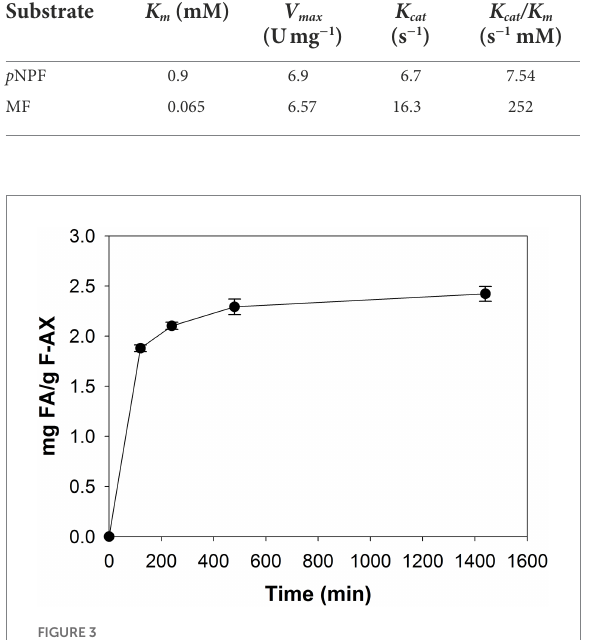
FIGURE 3 Degradation of feruloylated arabinoxylan. Release of FA from F-AX by incubation with Lb FAE for 24 h. Error bars indicate the mean ±